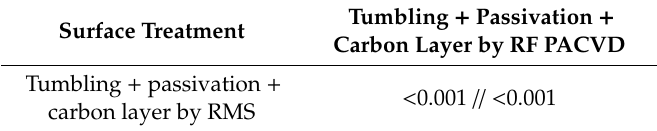
Table 5. Results of comparative adhesion of the carbon layer, indenter load F n [N], to the substrates. Surface treatment